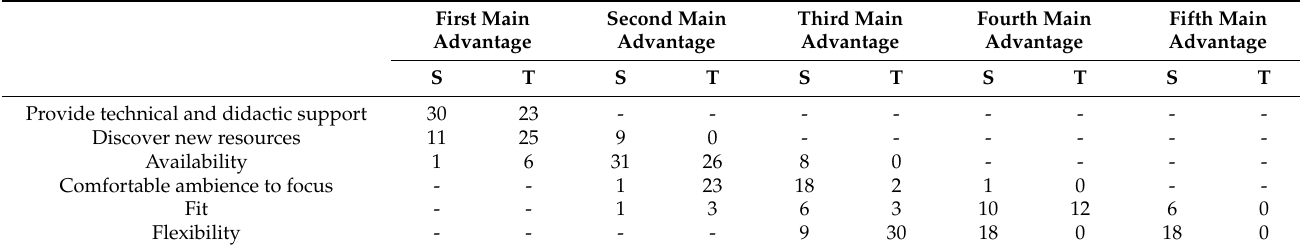
Table 10. Frequency of each advantage by choice order and by